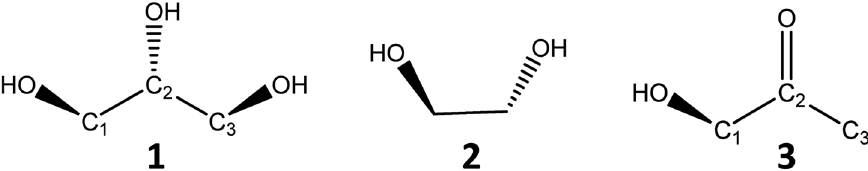
Figure 2. Organic molecules with labelled atom positions that were investigated as H·donors for the reduction of a hydroxymethyl radical to methanol. Reproduced from ref. [56] with permission from the Royal Society of Chemistry.